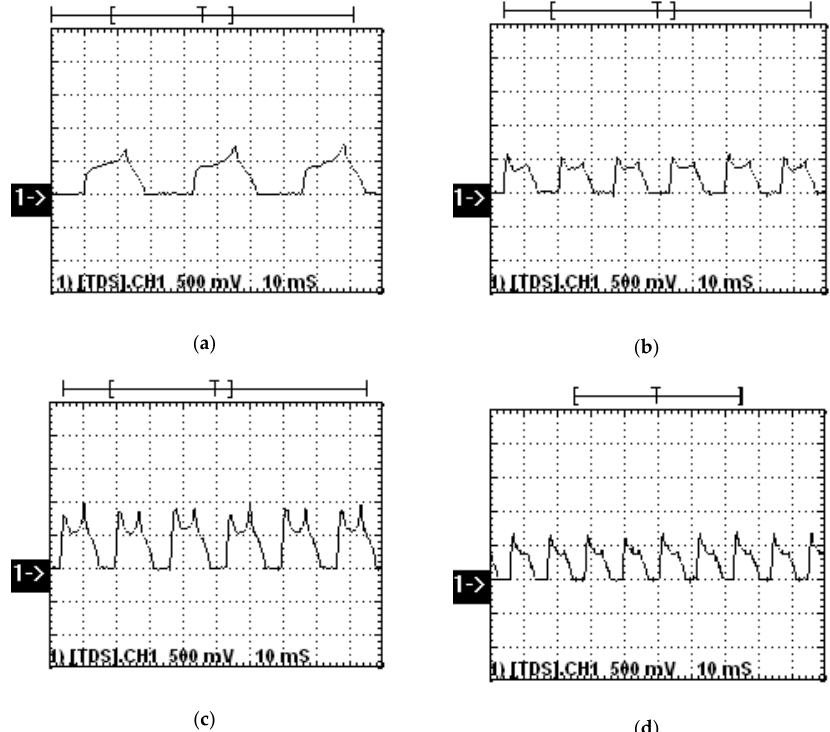
Figure 17. Tested phase current waveforms (ordinate: 5.0 A / div., abscissa: 10.0 ms / div.): ( a ) the rotor speed is n = 300 rpm and the load is T = 0.5 Nm; ( b ) n = 600 rpm and T = 0.5 Nm; ( c ) n = 600 rpm and T = 1.0 Nm; ( d ) n = 900 rpm and T = 1.0 Nm.